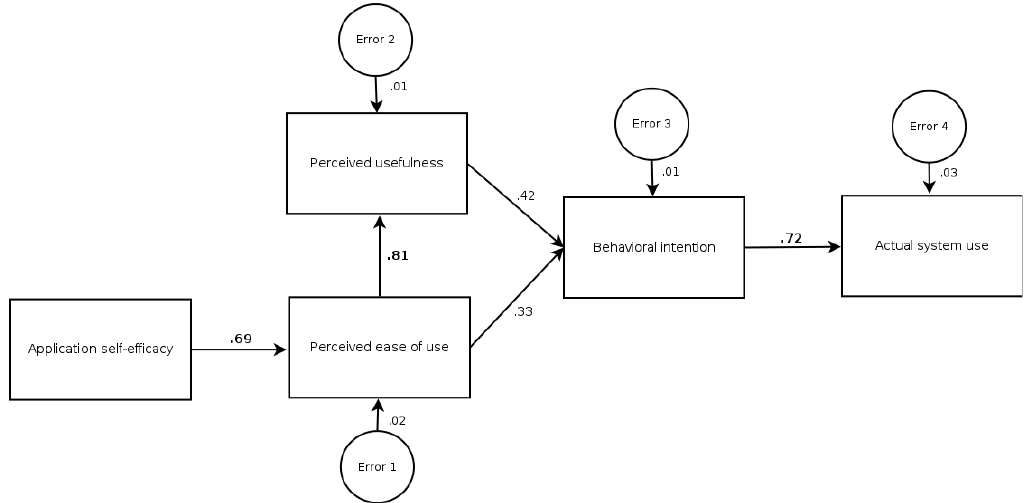
Figure 4 . TAM OER Model with β